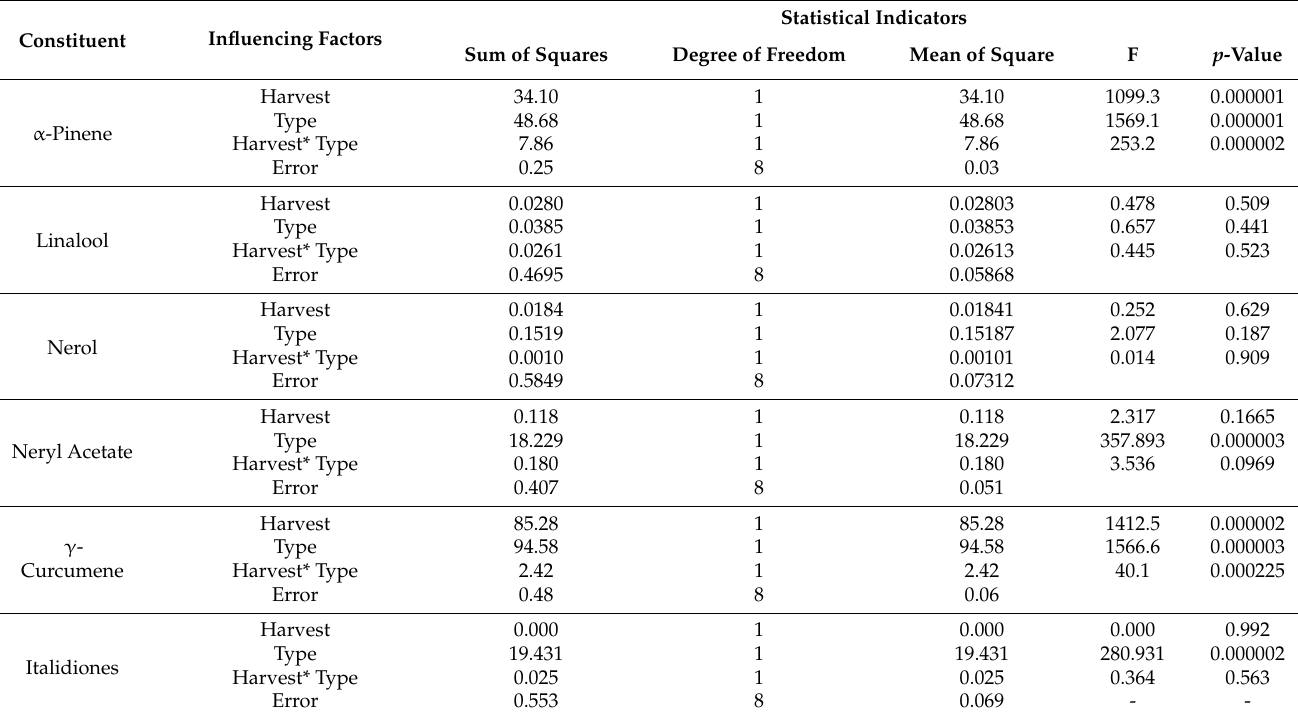
Table 3. Results of the analysis of the variance of the influence of the analyzed factors on the immortelle essential oil constituent at a significance level of p <